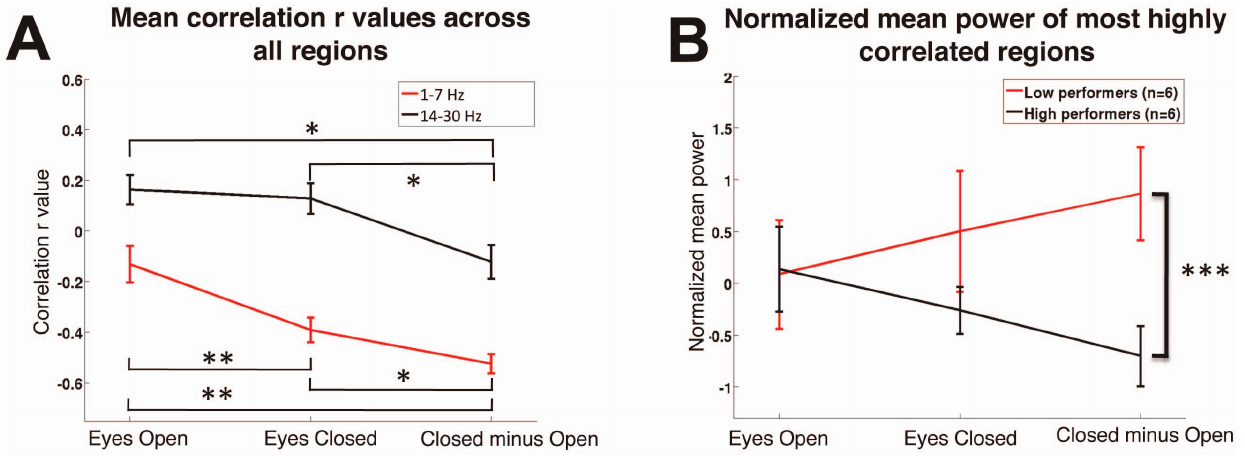
Figure 5. A: r values for all regions across conditions show a larger inverse correlation and a decrease in positive correlation in the zECO conditions. B: Using the most highly correlated normalized band and region comparisons (delta/theta right posterior frontal, delta/theta right parietal, beta right posterior frontal), high performers and low performers exhibit large differences in the zECO power across resting-state conditions. *=Bonferroni corrected p , 0.05. **=Bonferroni corrected p , 0.01. ***=single comparison p , 0.001.